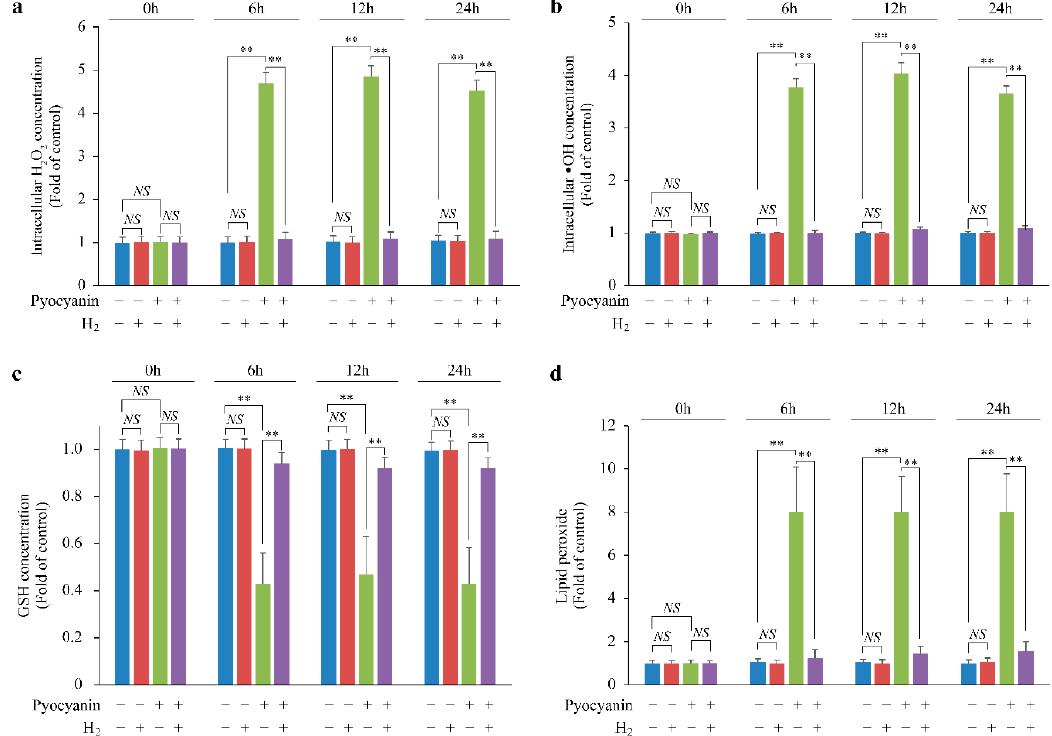
Figure 3. Scavenging of cyto • OH by H 2 suppressed lipid peroxide production and glutathione (GSH) depletion and indirectly maintained the increase in H 2 O 2 . ( a ) H 2 O 2 , ( b ) cyto • OH, ( c ) GSH, and ( d ) lipid peroxide concentrations in pyocyanin-stimulated MEFs. The data are presented as the mean ± SEM ( n = 5 per group); ** p < 0.01; NS, not significant.